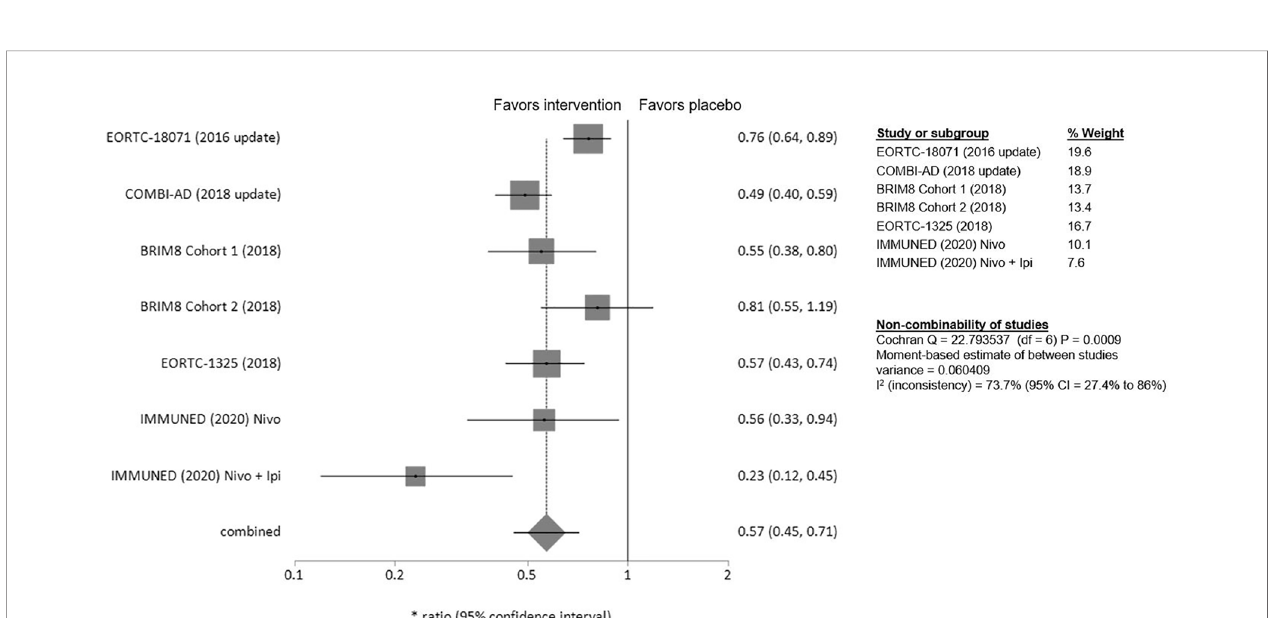
FIGURE 2 | Forest plot for primary outcome analysis on relapse free survival. Notes: Hazard ratio for relapse, or death along the x-axis, and results from all trials on the y axis with gray squares representing effect estimates and lines through them representing 95% CIs. The gray diamond represents the overall effect measure, which lies clear off the line of no effect and shows a bene fi t for the treatment groups compared to placebo with a summary hazard ratio of 0.57 (95% CI: 0.45 – 0.71). The percentage weight for each study is separately listed on the right side of the graph as well as the data on the heterogeneity of the meta-analysis, with the relevant measure being the I 2 score. CI, con fi dence